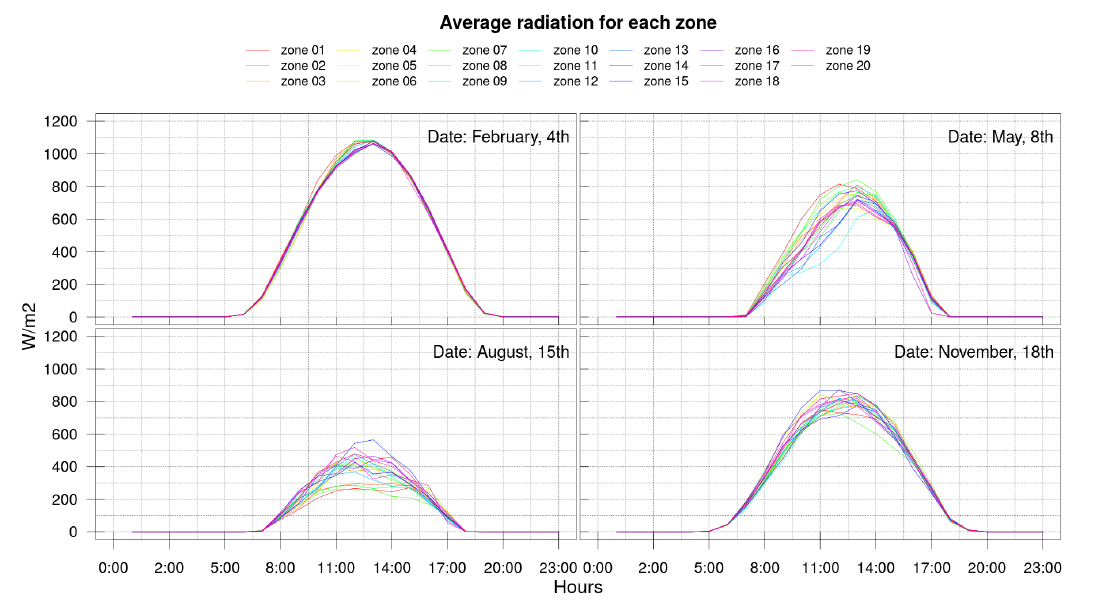
Figure 2. Representation of available average radiation for each studied